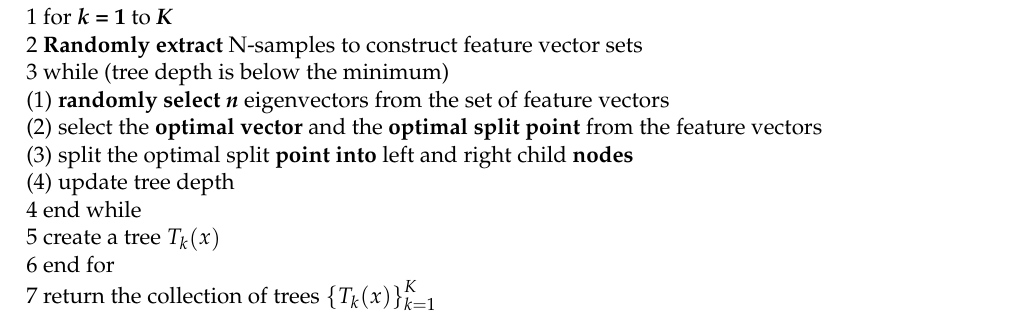
Table 2. Tree construction for a random